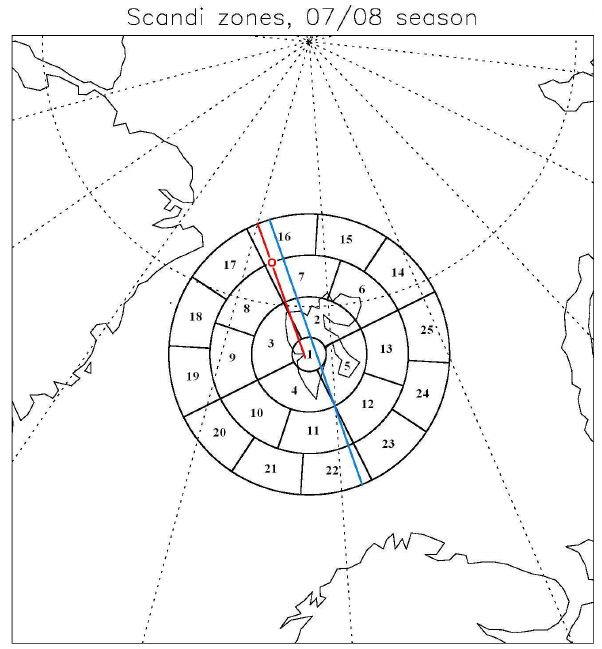
Figure 1: Map showing SCANDI field-of-view divided into 25 zones covering a latitude range 74°-82°N.